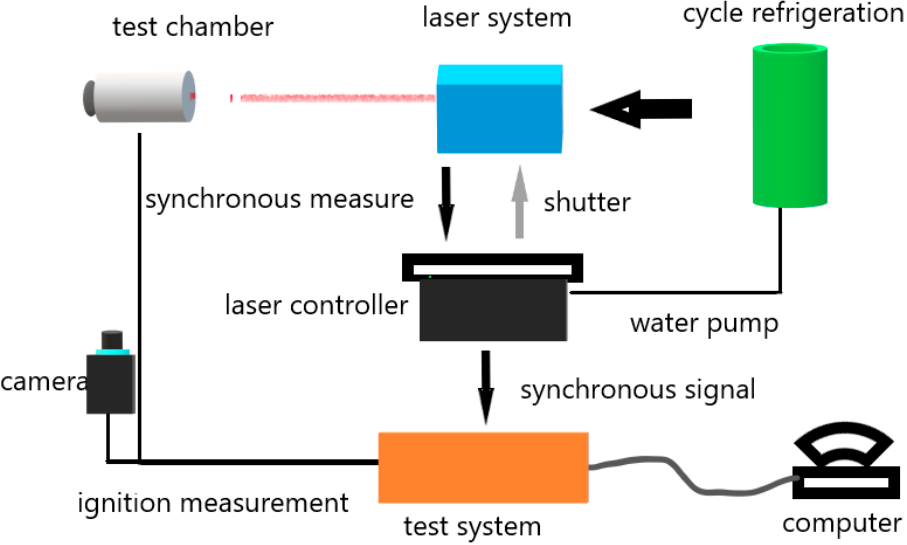
Figure 2. The schematic diagram of the experiment setup for combustion tests.